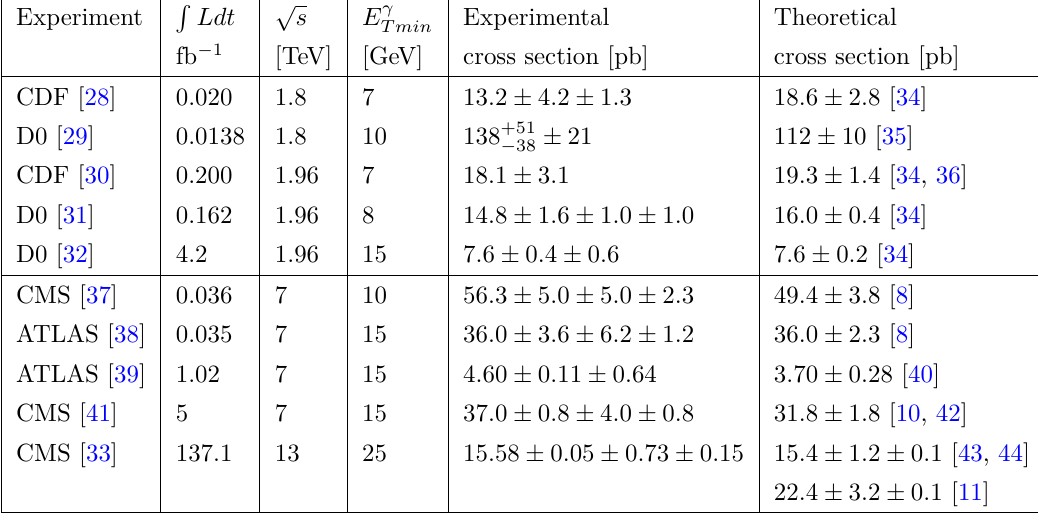
Table 1 . Experiments at various energies with p ¯ p and pp on the l ± νγ